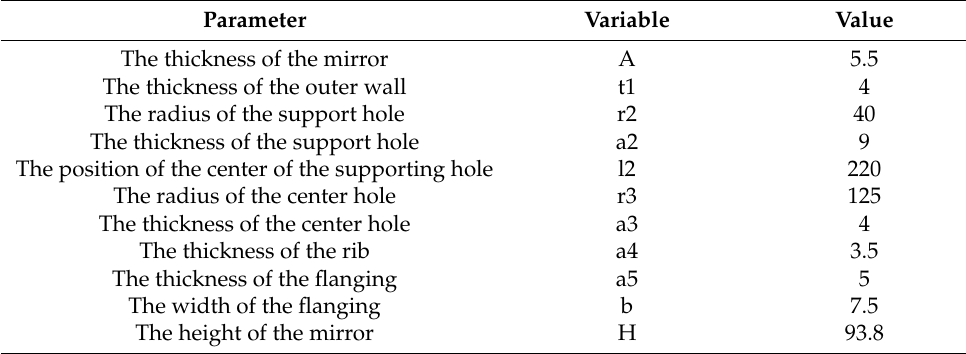
Table 1. Structural parameter values of the initial mirror